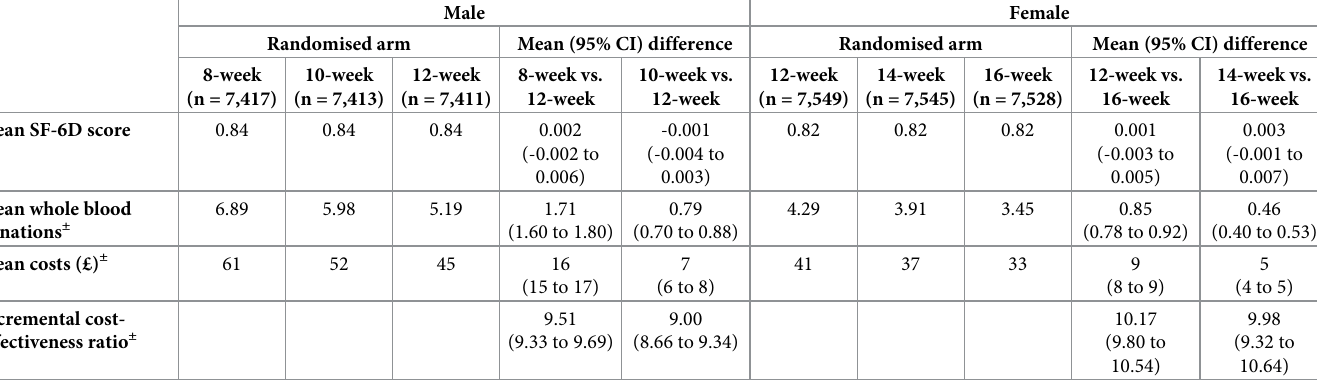
Table 3. SF-6D score (at two years), whole blood donations, costs and incremental cost per additional unit of whole blood donated, over two-year follow-up (by